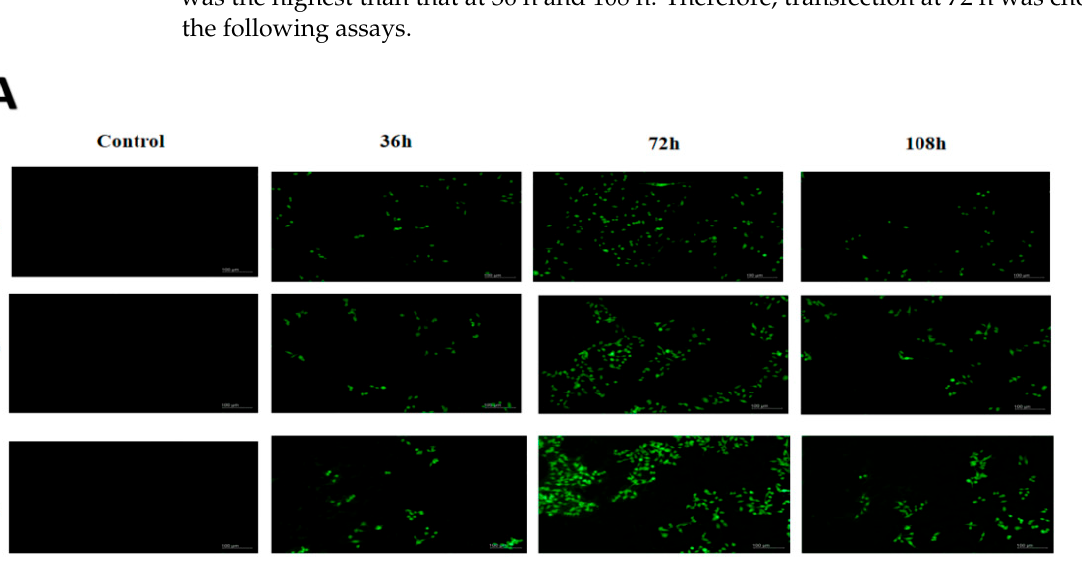
Figure 3. NaHS-induced phosphorylation of ROCK 2 or GFP-ROCK 2 at Tyr722 in the transfected RHNs. ( A ) Representative images of transfection. (( a ): Empty plasmid-transfected RHNs; ( b ):